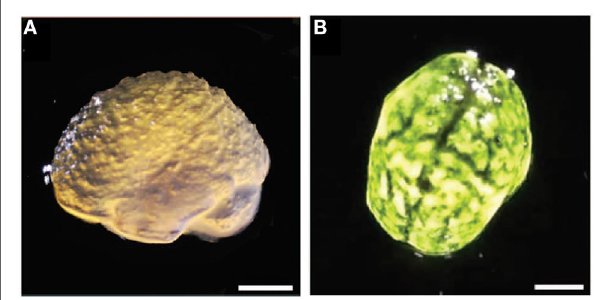
FiGURe 5 | (A) Lateral view of 3D printed alginate gel matching anatomical features of the cortex and cerebellum with microscale resolution. (B) Top view with black dye dripped on alginate gels. Scale bars = 1 cm. Reproduced with permission of Hinton et al. (2015), Creative Commons Copyright